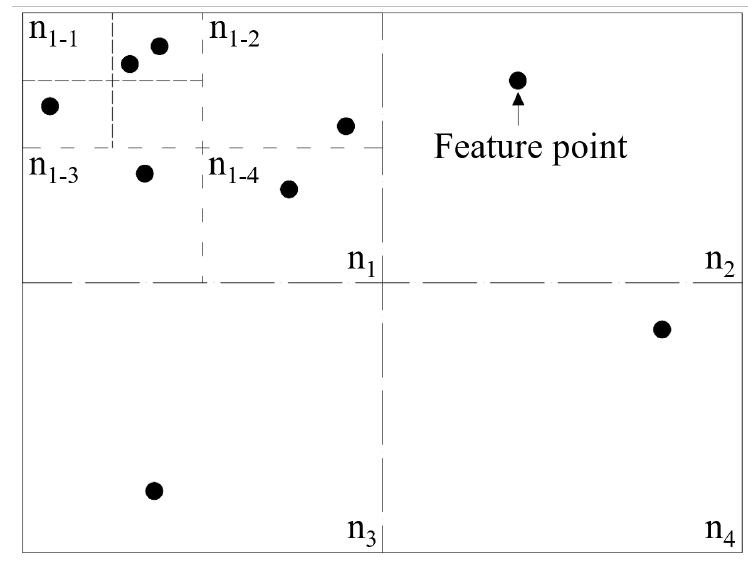
Figure 5. Schematic of the quadtree